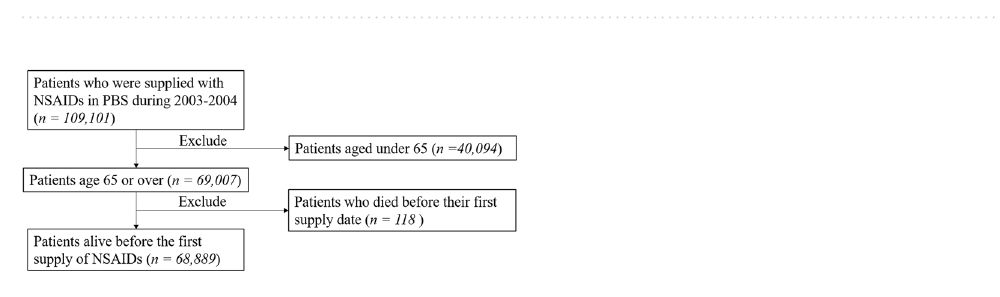
Figure 3. Flowchart showing identification of the study cohort. ACS, acute coronary syndrome. The figure was created using Microsoft PowerPoint 365, available from: https:// office. micro soft. com/ Power